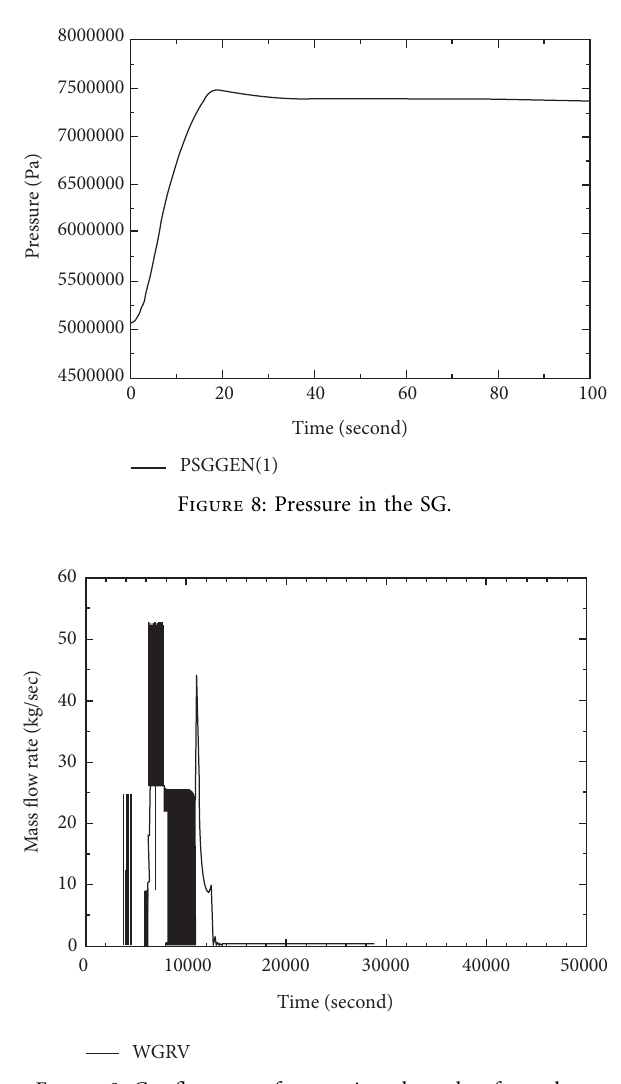
Figure 9: Gas flow rate of pressurizer through safety valves.